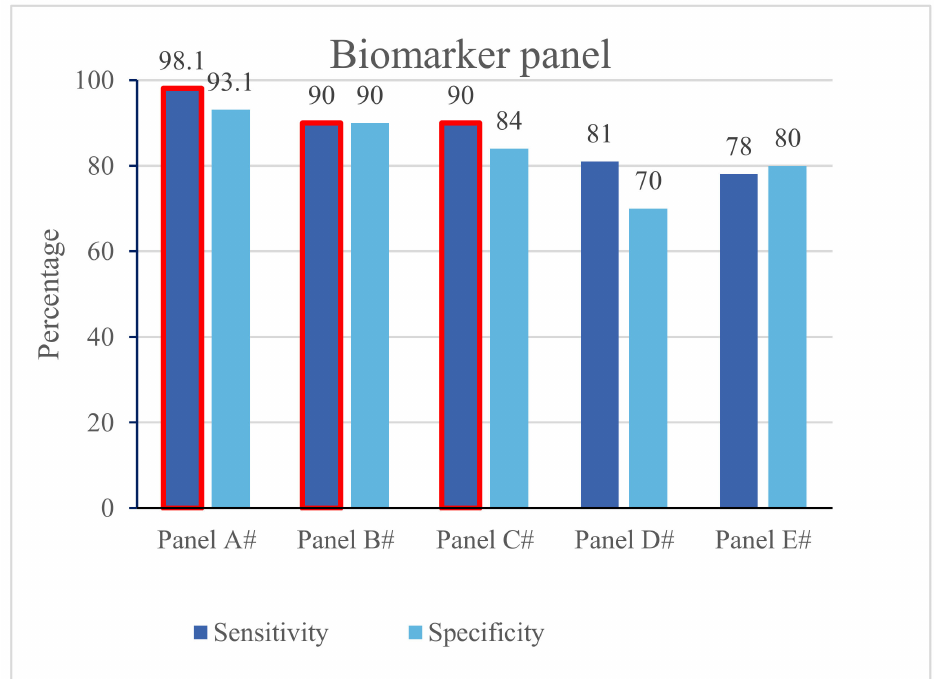
Figure 3. Panel biomarkers for stroke. Panels A, B and C have sensitivity of 90% or higher, which are highlighted in red. NB: The reported sensitivity and specificity for panels A, B, D, and E are related to ischaemic stroke